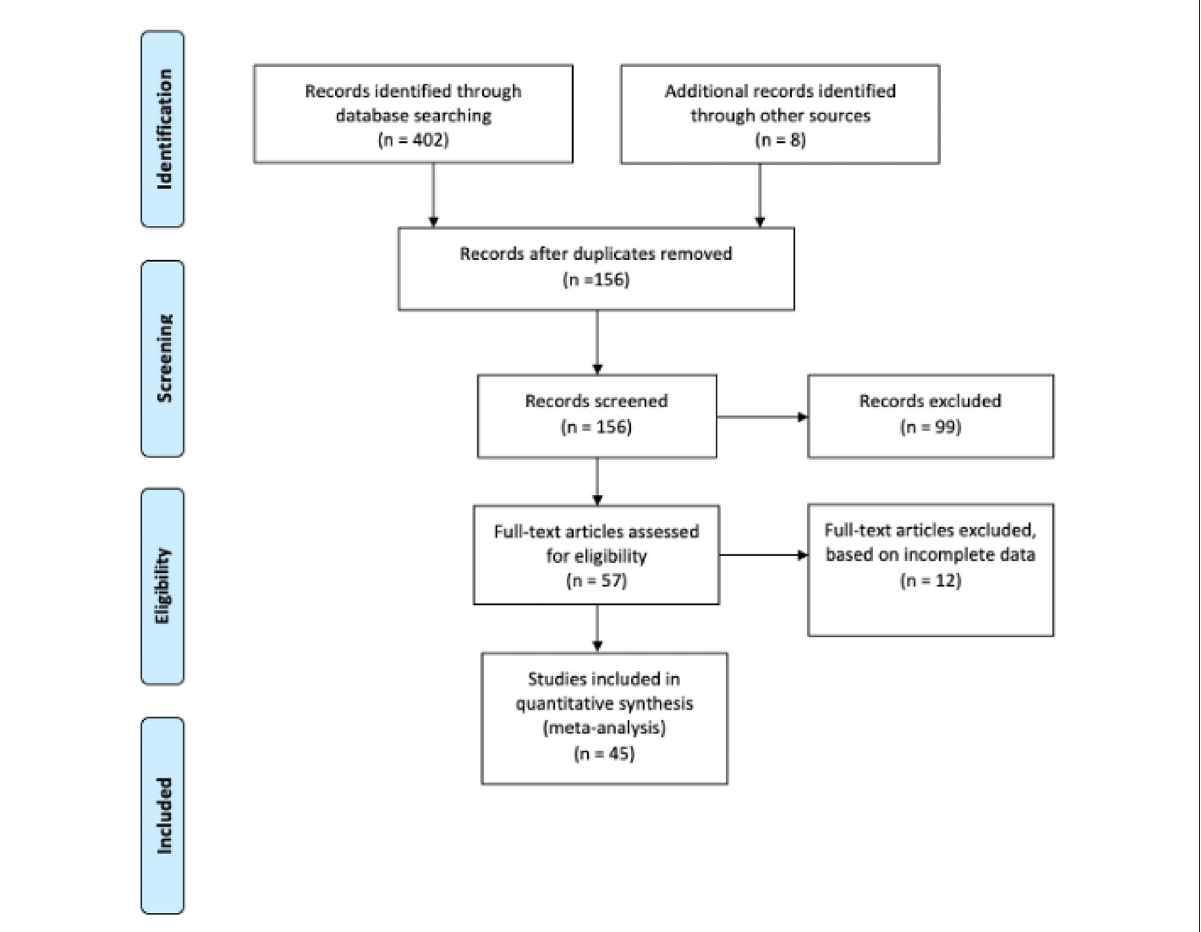
FIGURE1 Flowchart of the selected